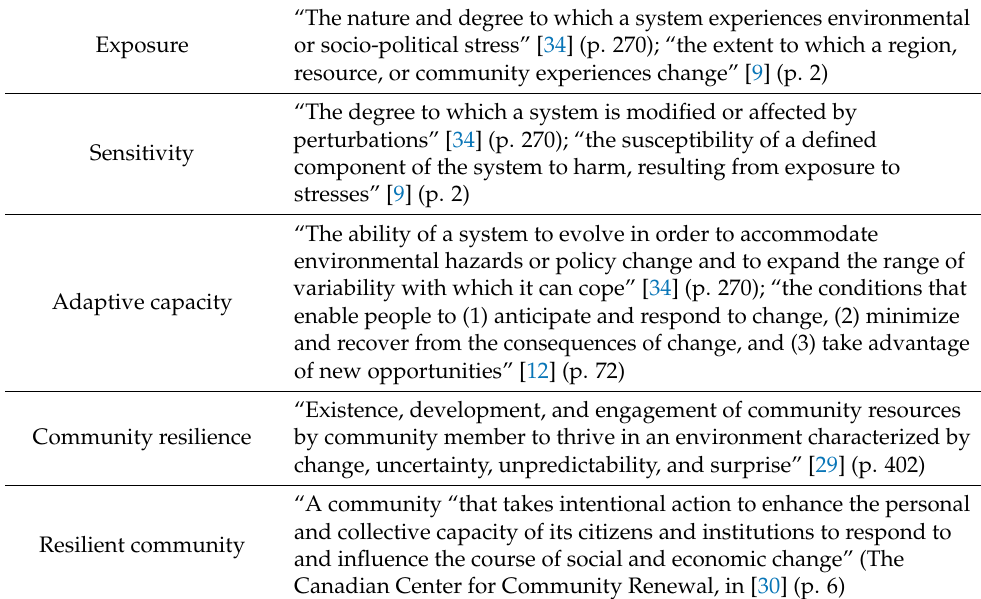
Table 1. Key Conceptual